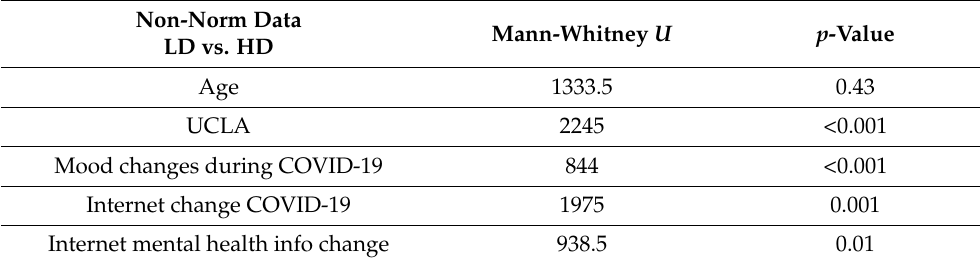
Table 4. Mann Whitney- U test results between LDs and